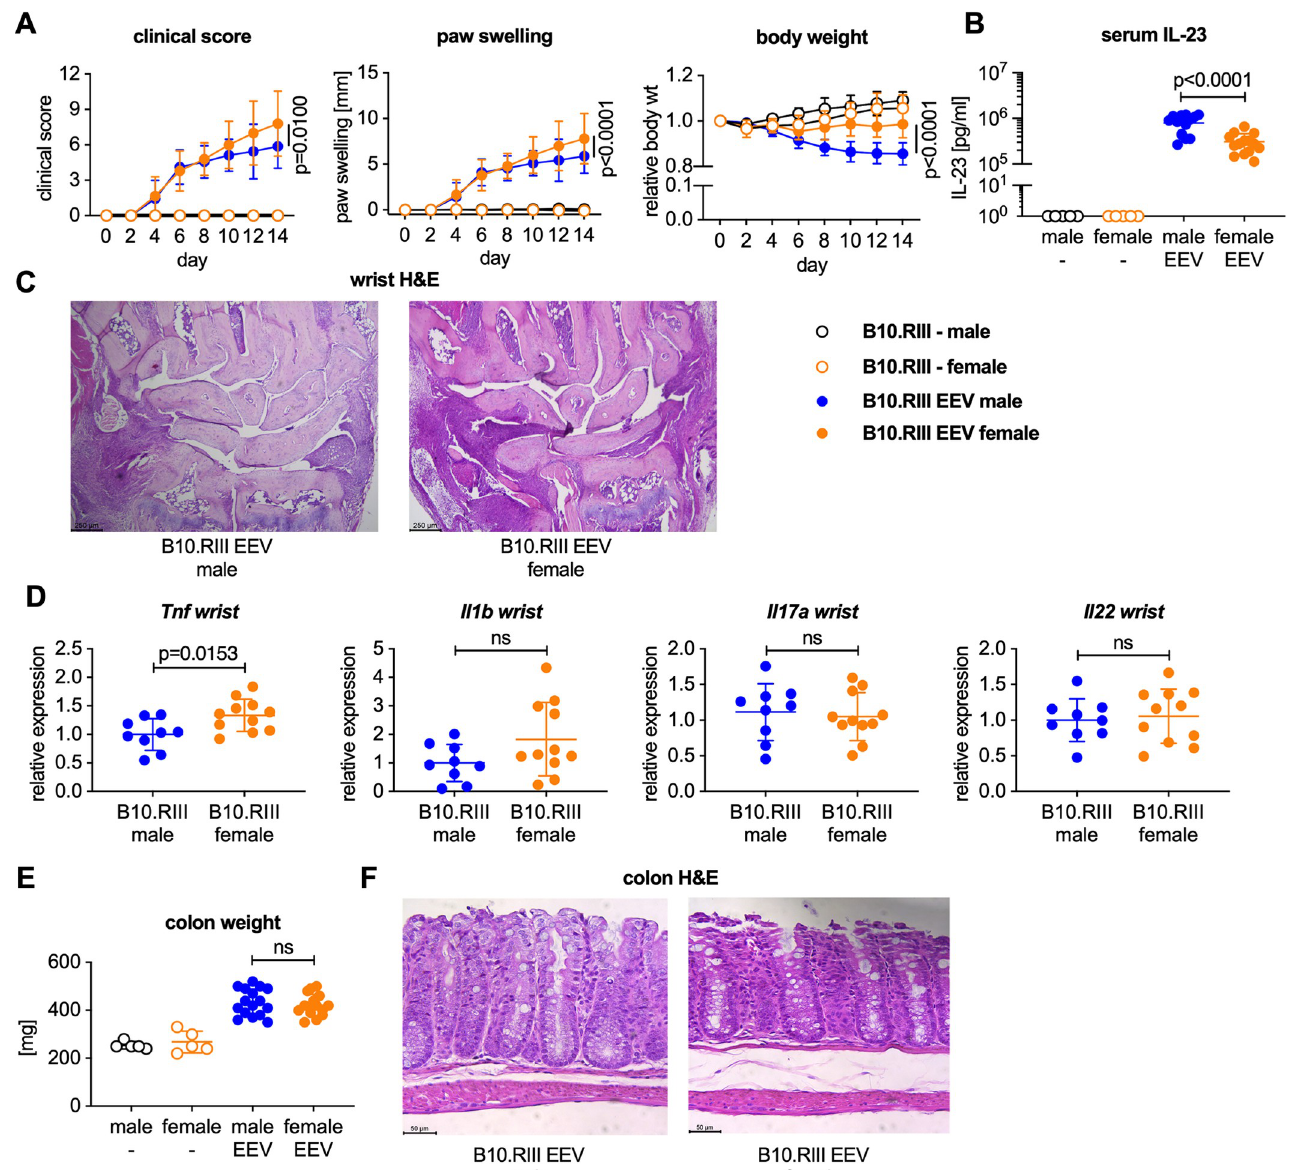
Fig 8. Female B10.RIII mice develop more severe arthritis than males but do not lose weight after hydrodynamic injection of IL-23 EEV. 8–12 week-old male and female B10.RIII mice received 500 ng IL-23 EEV on day 0 via hydrodynamic tail vein injection; control mice received no injection (n = 14 mice in IL- 23 EEV injected groups, n = 5 mice in control groups). (A) Clinical score (mean ± SD). Paw swelling (mean ± SD). Body weight (mean ± SD). (B) Serum IL-23 on day 14 was determined by ELISA. (C) Representative H&E stained sections of day 14 wrists, scale bar 250 μ m. (D) Gene expression analysis in the wrists on day 14 (n = 9–11 mice/group). qPCR data for individual samples were first normalized by Hprt expression and then divided by the mean of the IL-23 EEV injected males. P values were determined by unpaired t-test. (E) Colon weight on day 14. (F) Representative H&E stained colon sections from male and female B10.RIII IL-23 EEV injected mice, scale bar 50 μ